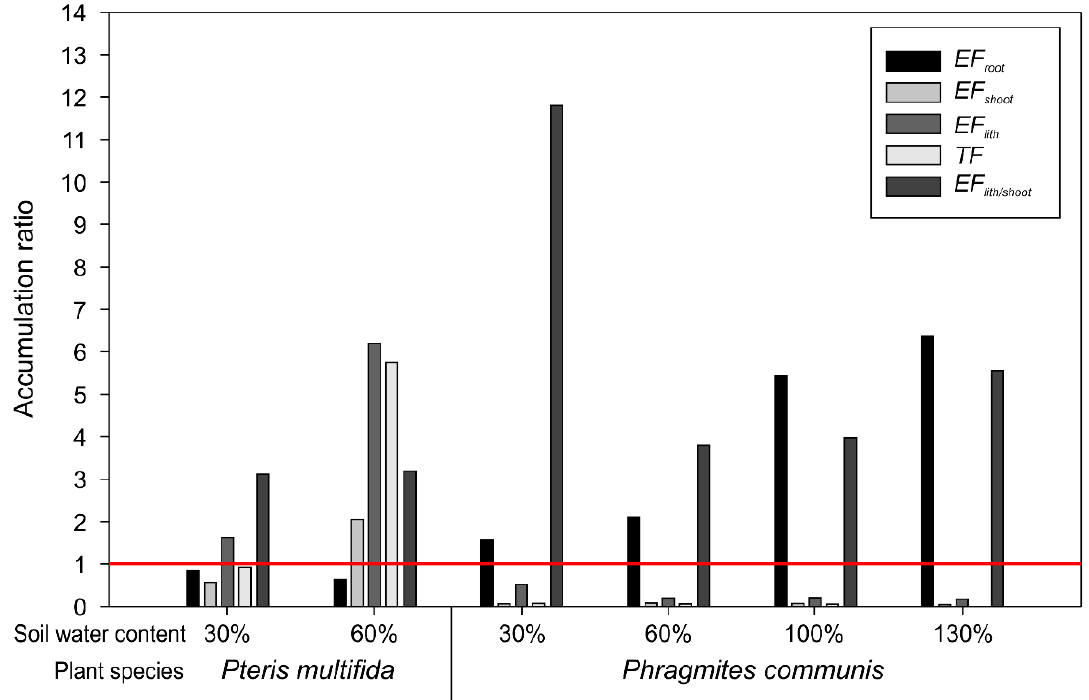
Figure 3. Arsenic accumulation ratio from soil to plant in Pteris multifida and Phragmites australis as a function of the water content. Soil water content means the percentage of water holding capacity. Accumulation ratio of 1 is marked with a red horizontal line. The EF root is As concentration in root per As concentration in soil determined via Mehlich-3 extraction. EF shoot is As concentration in shoot per As concentration in soil determined via Mehlich-3 extraction. EF lith is As concentration in phytolith per As concentration in soil determined via Mehlich-3 extraction. TF is As concentration in plant shoot per As concentration in plant root. EF lith/shoot is As concentration in phytolith per As concentration in soil determined via Mehlich-3 extraction.